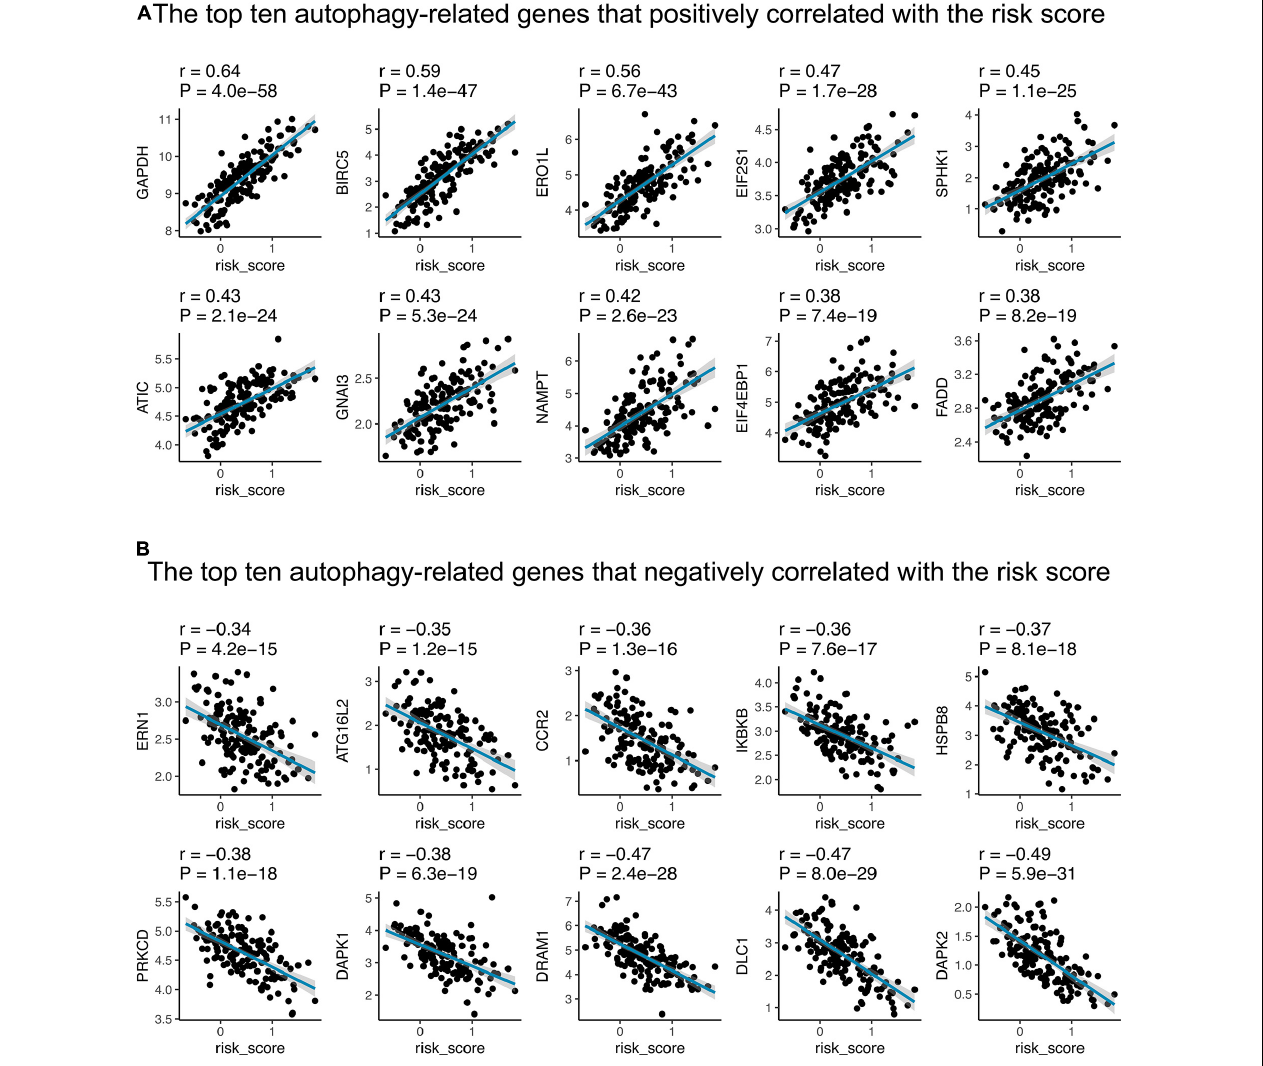
FIGURE 6 | The correlations between the 15-gene signature and autophagy-related genes in the training cohort. The figure shows the top ten autophagy-related genes that positively (A) and negatively (B) correlated with the risk score, respectively. The blue line in each graph fits a linear model that indicates the proportional trend of expression level of each gene and the risk score. The shading around the blue line represents the 95% confidence interval. The Pearson coefficient was applied for correlation